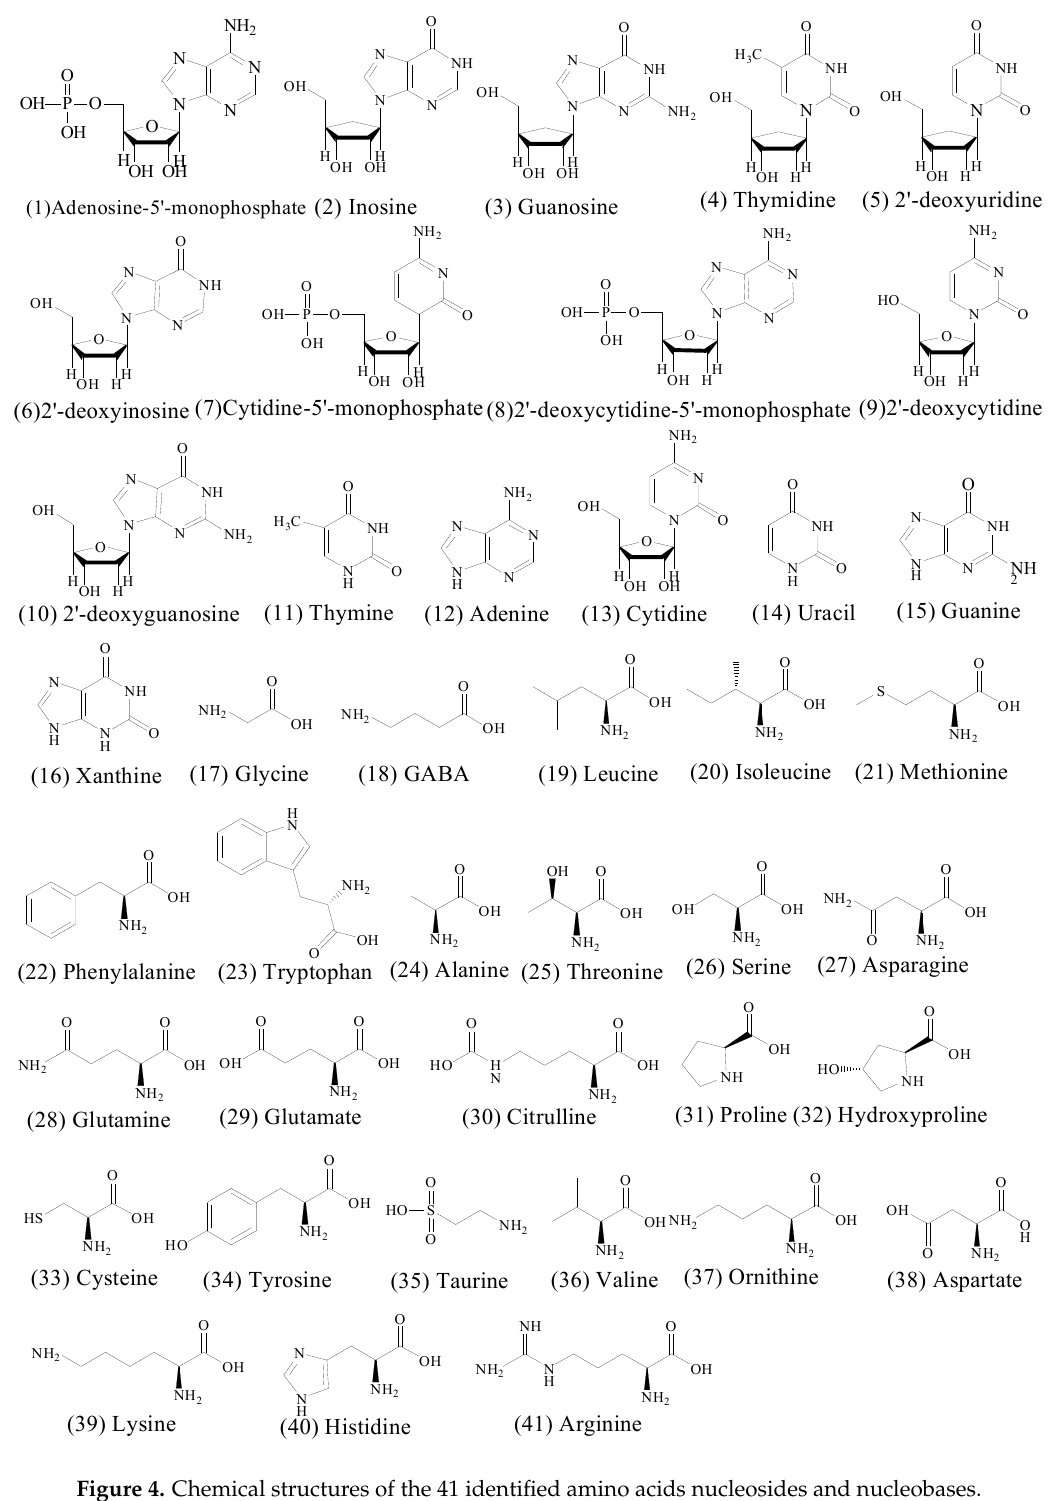
Figure 4. Chemical structures of the 41 identified amino acids nucleosides and nucleobases.